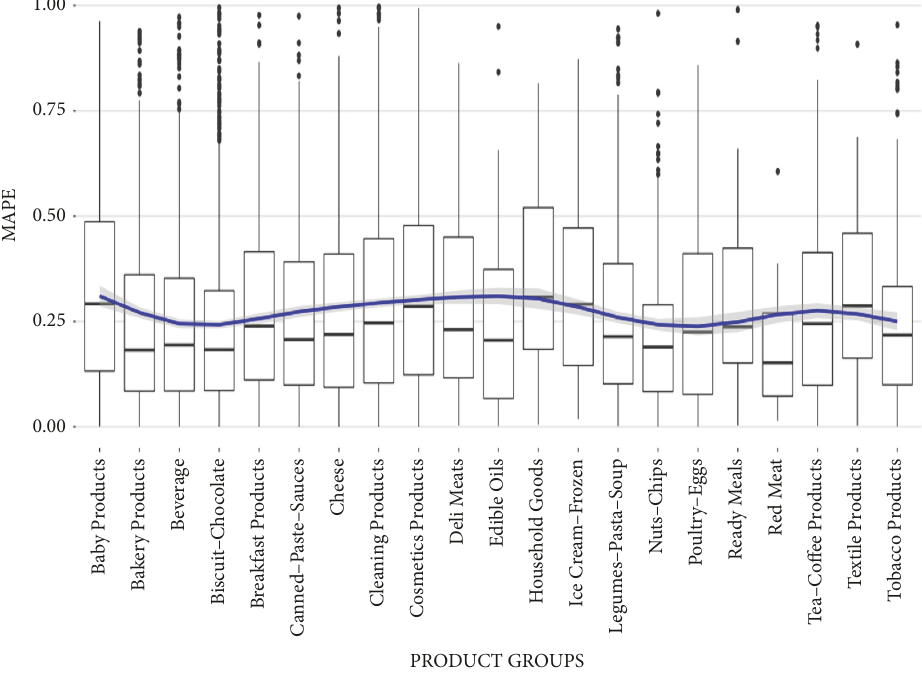
Figure 4: MAPE distribution according to product groups after deep learning